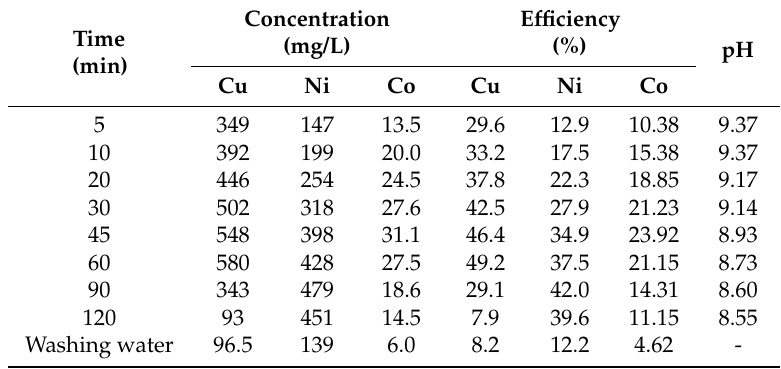
Table 4. Metals concentration and extraction efficiency of ammoniacal leaching at 85 °C.